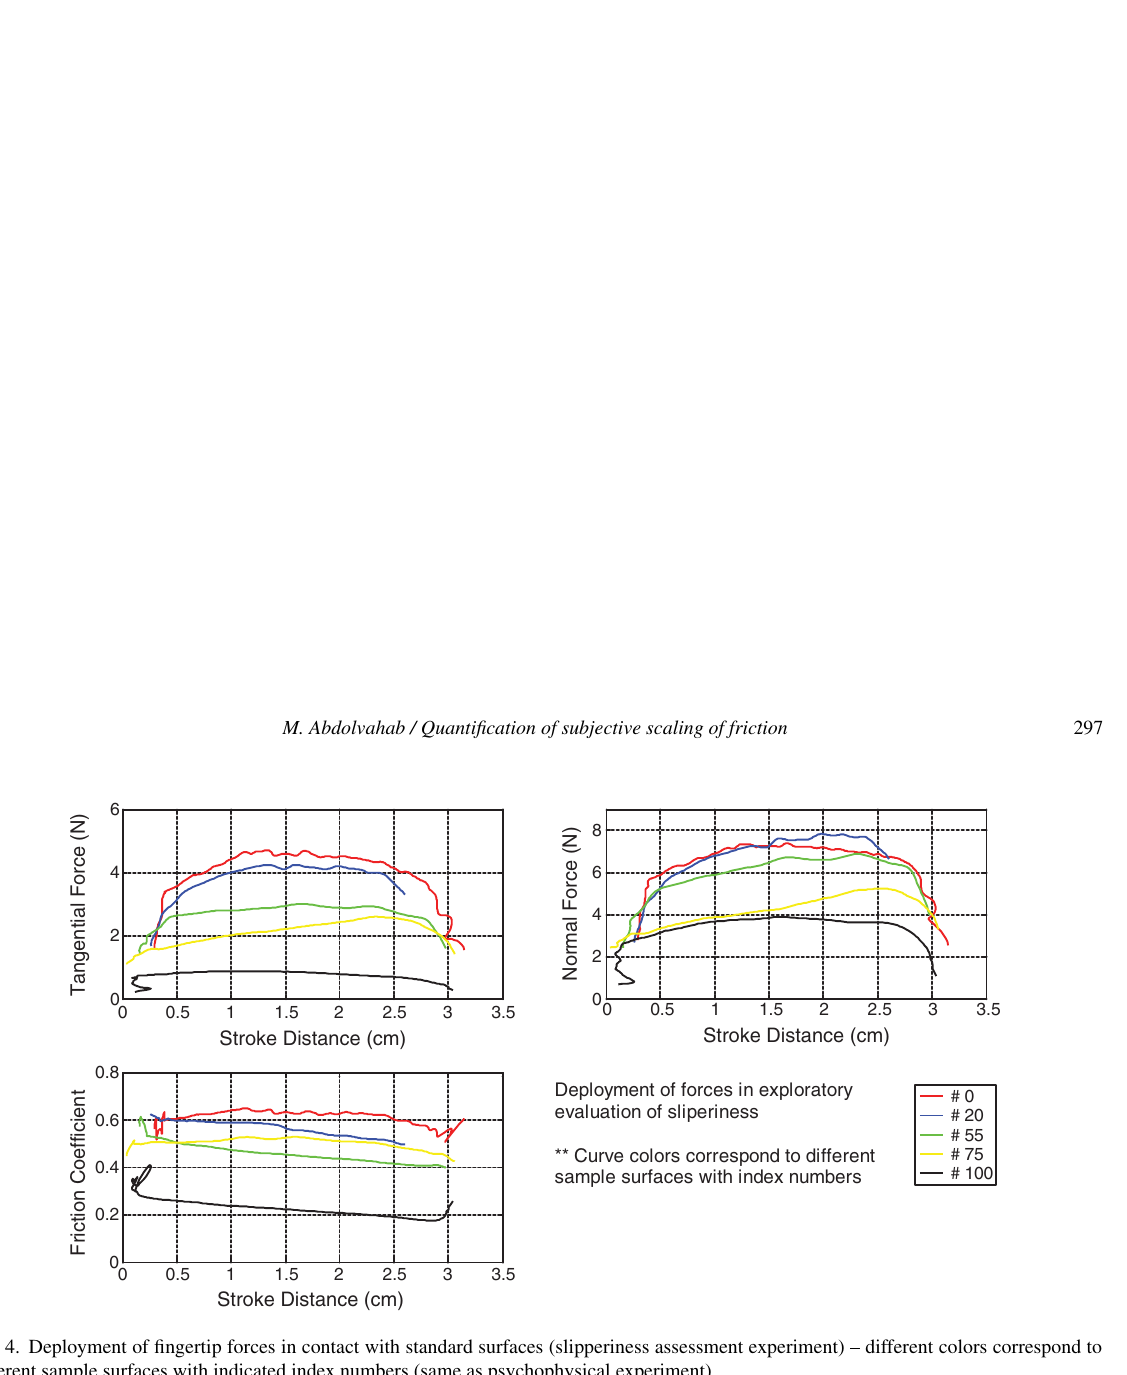
Fig. 4. Deployment of fingertip forces in contact with standard surfaces (slipperiness assessment experiment) – different colors correspond to different sample surfaces with indicated index numbers (same as psychophysical